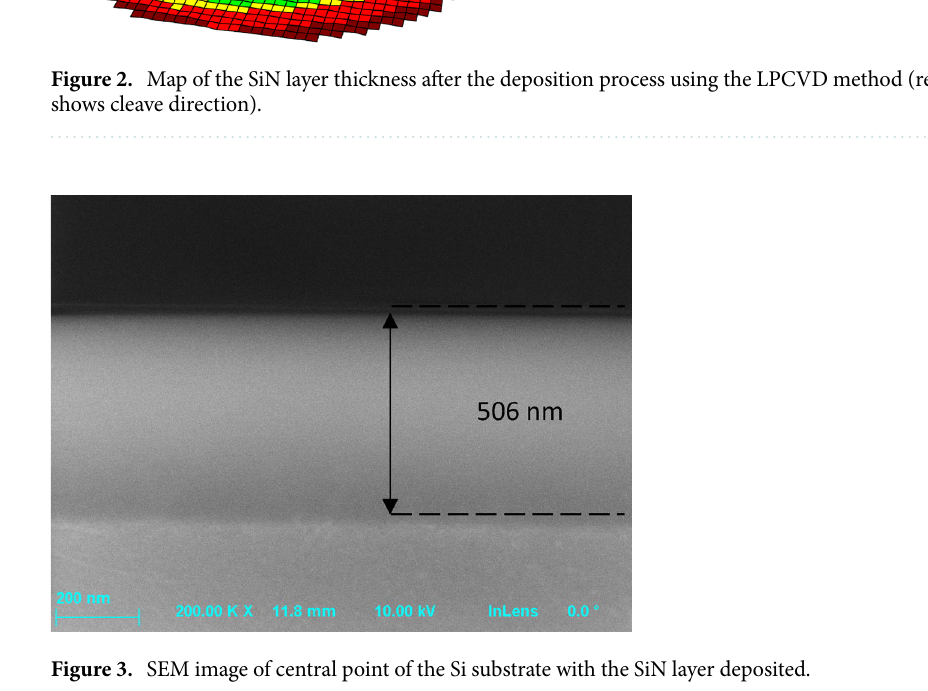
Figure 3. SEM image of central point of the Si substrate with the SiN layer deposited.